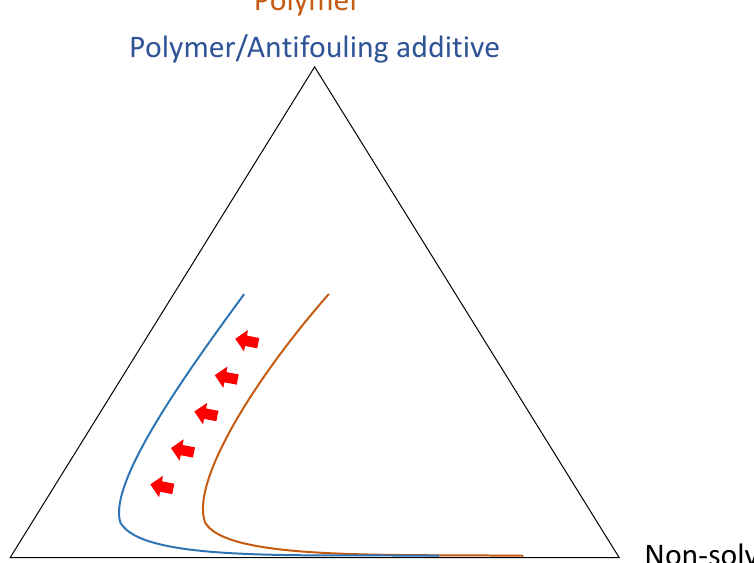
Figure 4. Schematic effect of the antifouling additive on the position of the demixing gap. Red arrows highlight the shift of the binodal line towards the solvent/polymer axis.